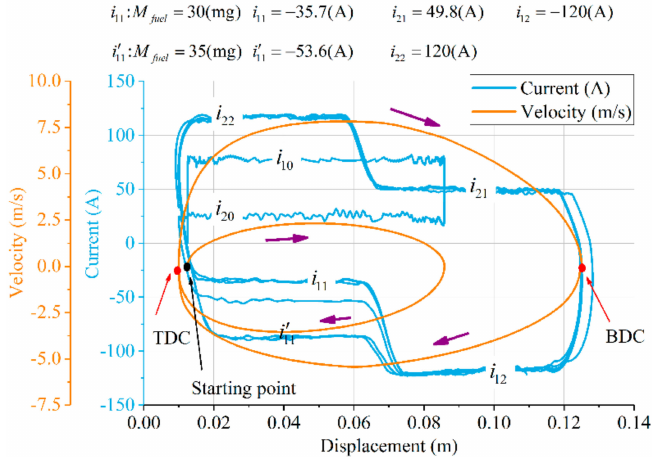
Figure 15. Phase trajectory and currents of the ladder-like control